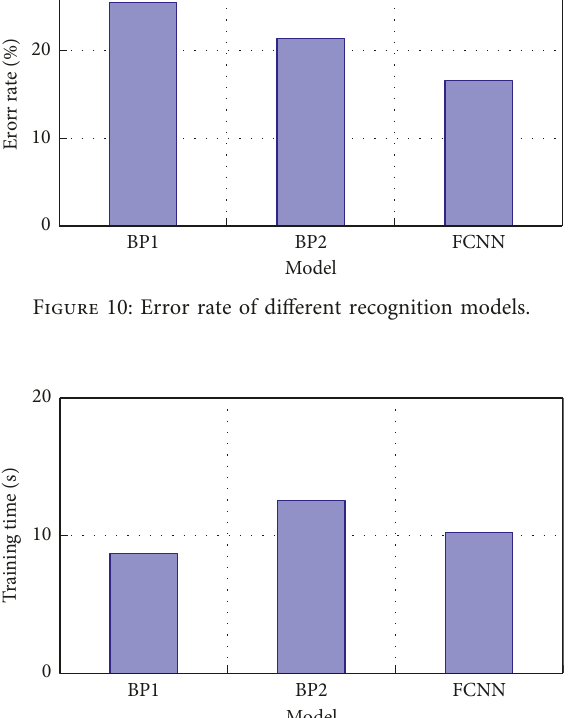
Table 3: Comparison of the different number of nodes in the hidden layer.